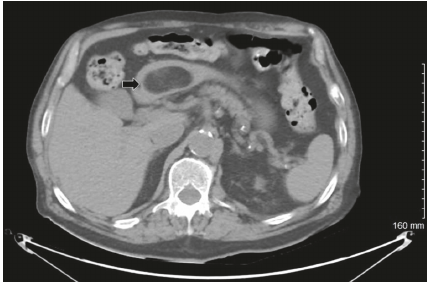
Figure 2: Computerized tomography abdomen. Black arrow show- inggastricantralsubmucosalmasswhichishomogeneousindensity and has sharp rounded borders. This is indicative of gastric lipoma.